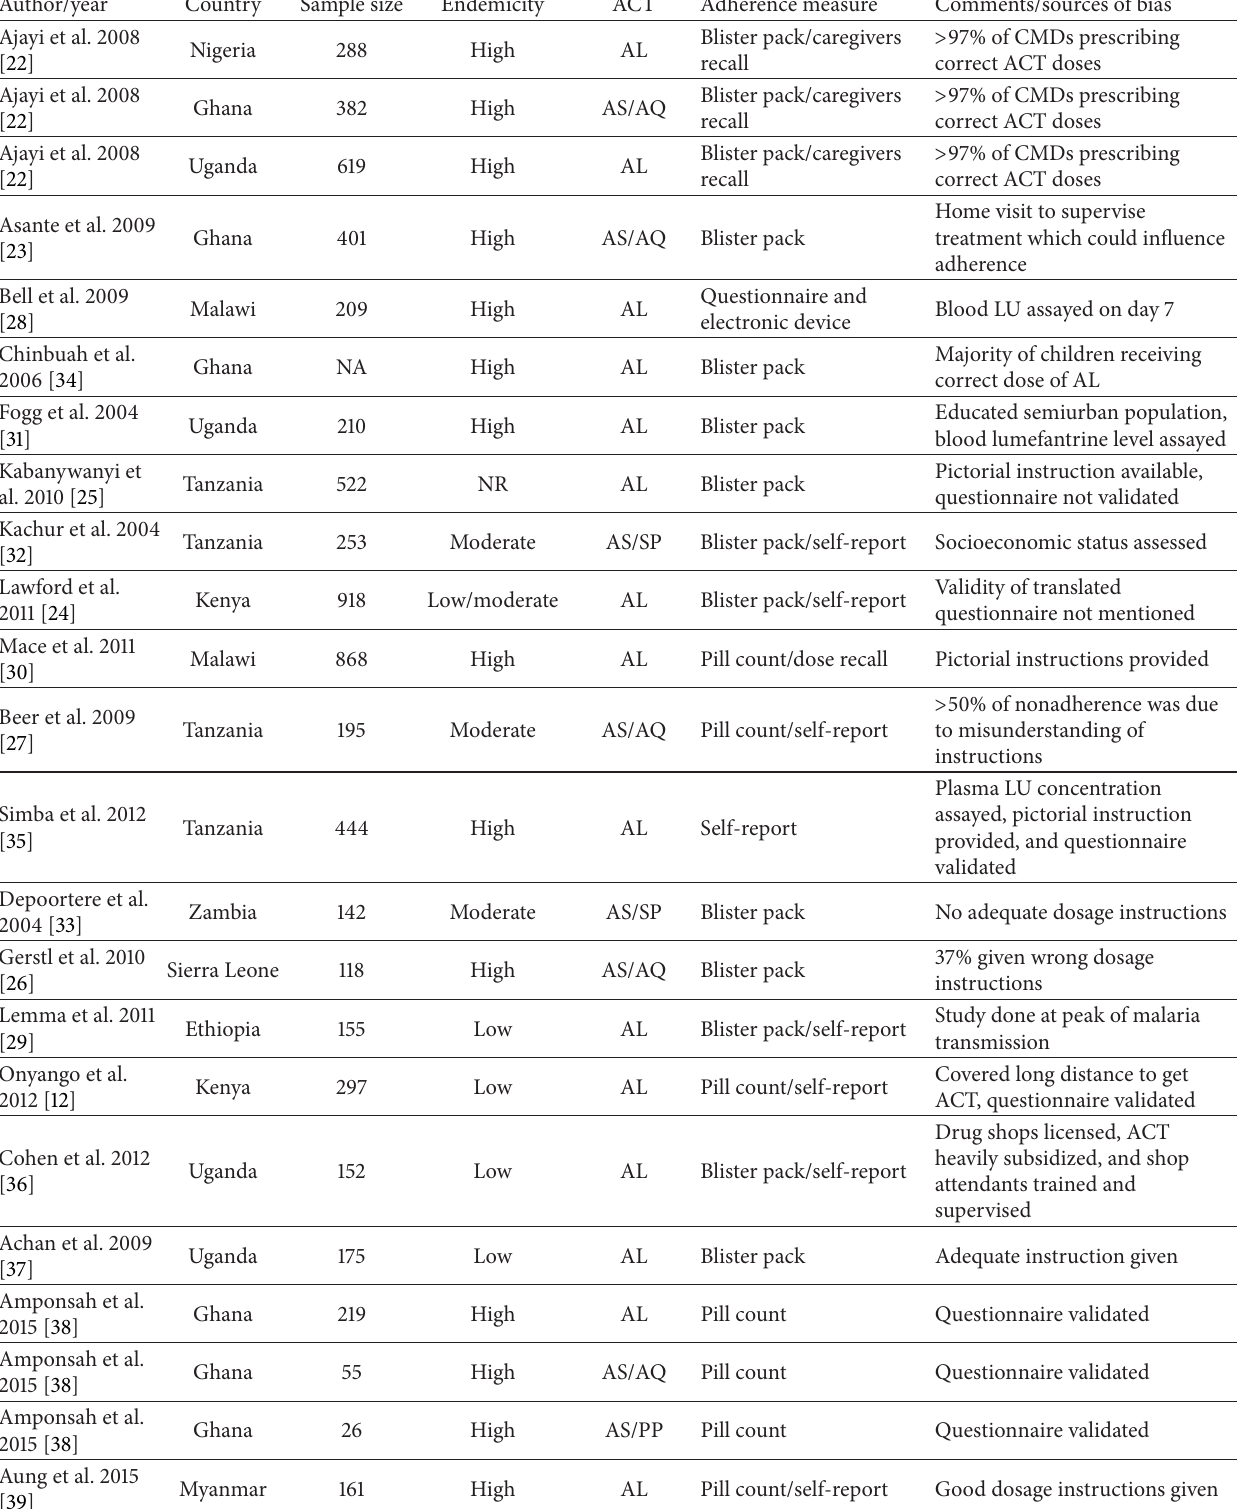
Table 1: Characteristics of studies included in the systematic review and